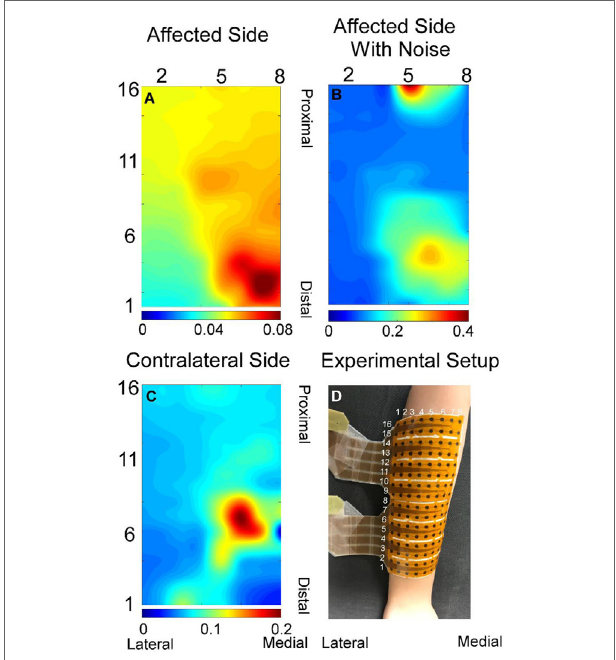
FIgURe 1 | Exemplar root-mean-square map for index finger from both affected (a) and contralateral sides (C) . (B) Root-mean-square map of panel (a) with background noise and motion artifact without filtering. (D) Experiment electrode placement. All root-mean-square maps were calculated from the trapezoid 50% contraction. All the X and Y axis labels indicate the row or column number of the electrodes.